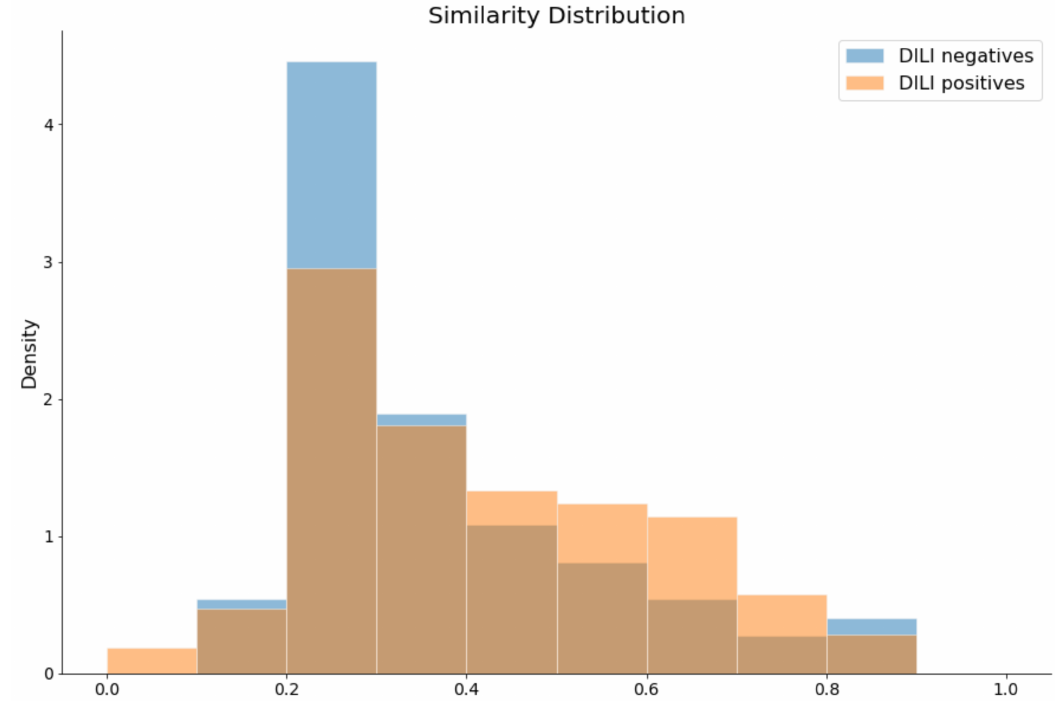
Figure 3. Histogram of maximum similarities for each DILI class. The graph indicates that the DILI-negatives in the validation data set had a more biased distribution of the maximum similarity, ranging from 0.2 to 0.3, than DILI-positives in the same data set. This indicates that the DILI-negatives structurally varied more than the